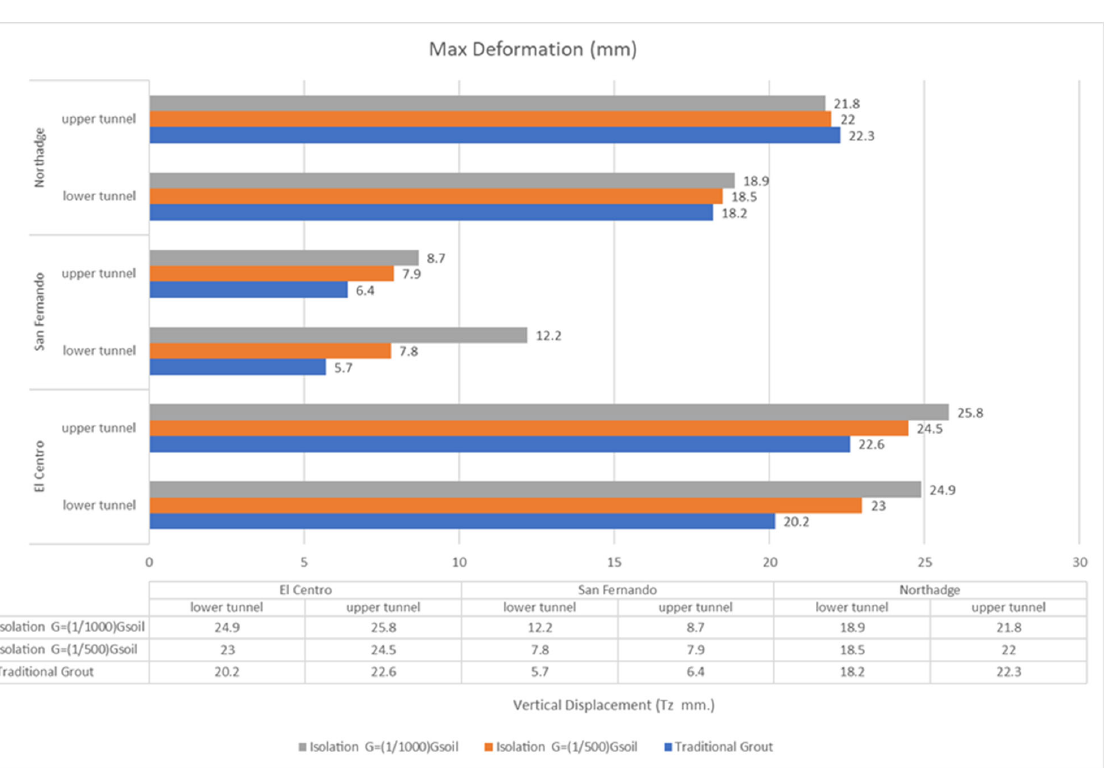
Figure 15. Maximum vertical displacement of twin tunnels in stiff soil.